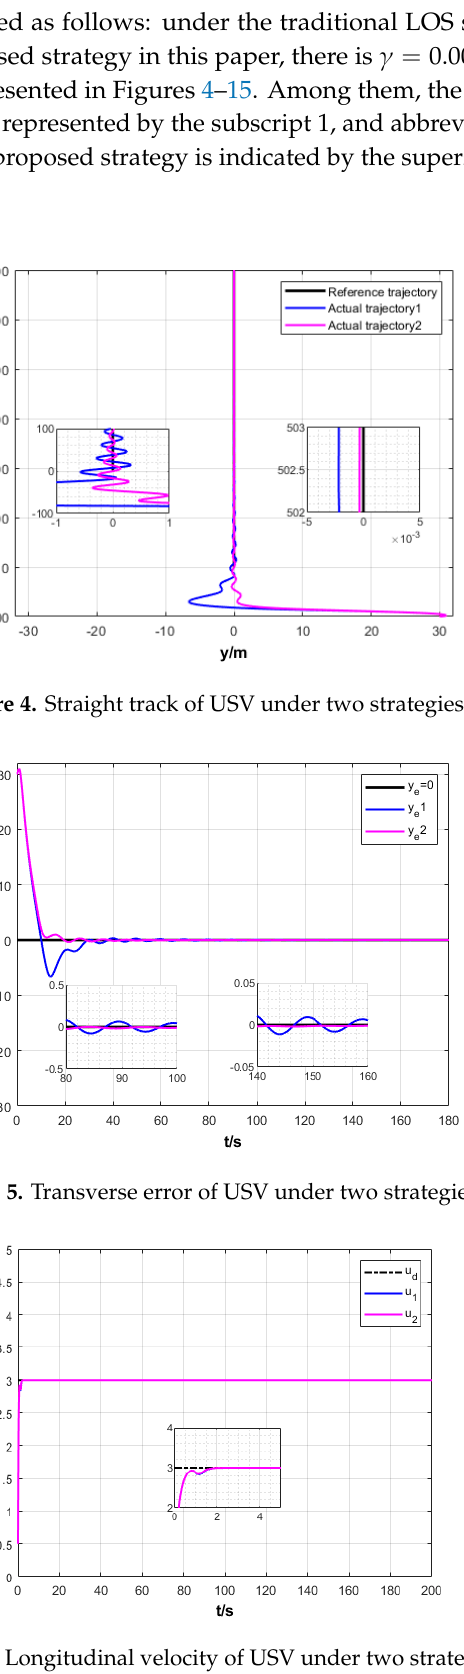
Figure 6. Longitudinal velocity of USV under two strategies.